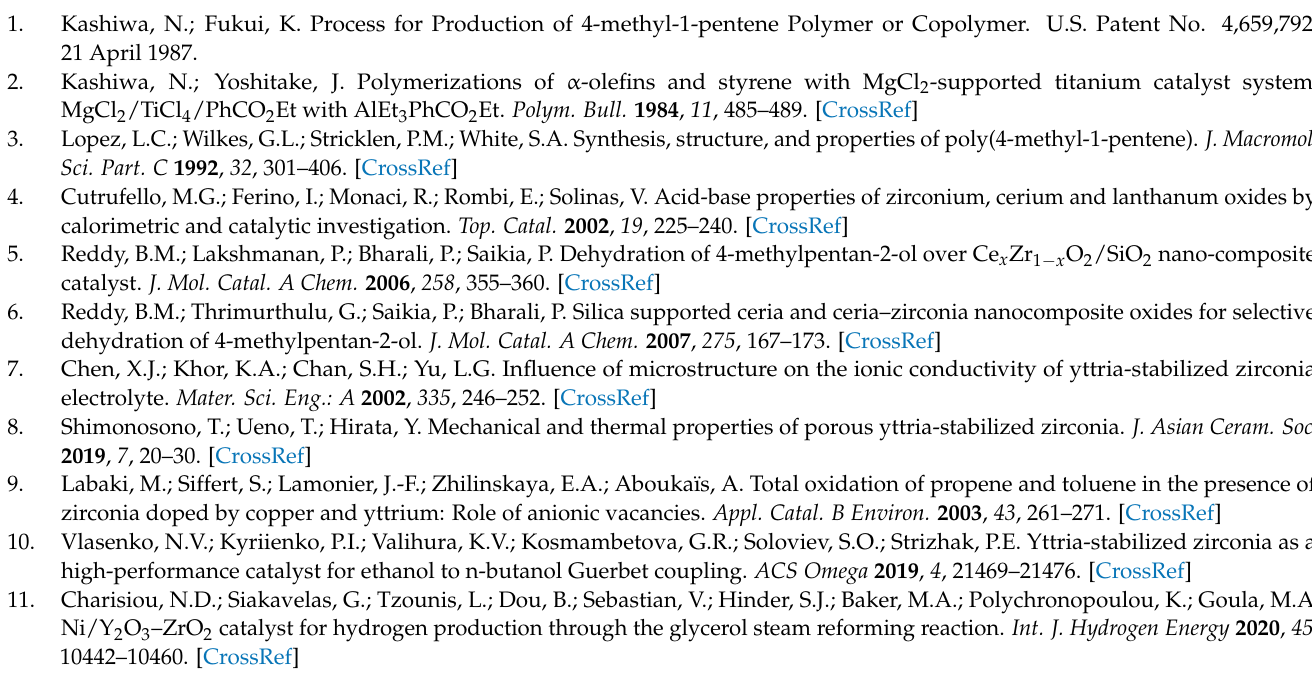
Figure S4: Ratio of cis - to trans -4M2P at 350, 375, and 400 ◦ C over the co-precipitated x YSZ ( x = 4, 8, 20, and 30) and impregnated x Y/ t -ZrO 2 ( x = 4 and 20) catalysts along with bare t -ZrO 2 , Figure S5: Pyridine-chemisorbed FT-IR spectra of the catalysts 4YSZ and 4Y/ t -ZrO 2 , Figure S6: XPS spectra of the impregnated Y/ t -ZrO 2 catalysts in the core levels of (a) Zr 3d, (b) Y 3d, and (c) O 1s. The spectra of t -ZrO 2 and/or Y 2 O 3 are added for comparison, Figure S7: Correlation of 4M2Pol conversion with the surface density of total acid sites, weak base sites, and total base sites of x YSZ (filled squares), x Y/ t - ZrO 2 (open triangles), and bare t -ZrO 2 (open squares), Figure S8: Correlation of 4M1P selectivity with various surface density ratios. (a) Weak acidity to weak, medium, and total basicity. (b) Total acidity to weak, medium, and total basicity for x YSZ (filled squares), x Y/ t -ZrO 2 (open triangles), and bare t -ZrO 2 (open squares), Figure S9: Plausible mechanism on the conversion of 4M2Pol. (a) Formation of 4M2P via E1 mechanism over YSZ. (b) Formation of 4M2Pon via dehydrogenation mechanism over